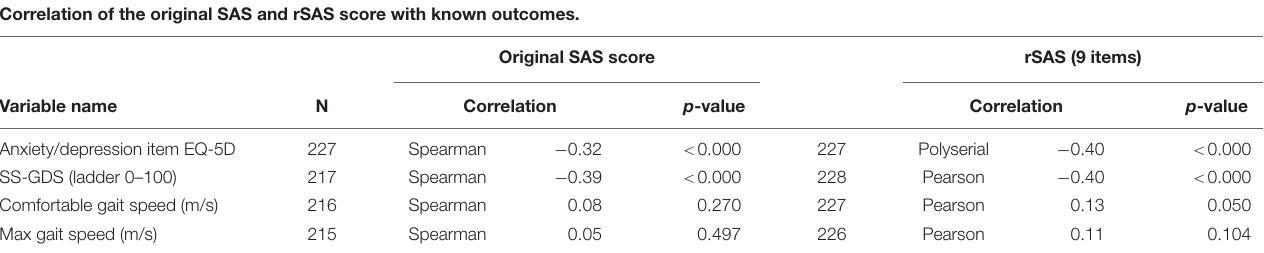
TABLE 4 | Relationship between rSAS apathy total score and measures used to support interpretability. Correlation of the original SAS and rSAS score with known